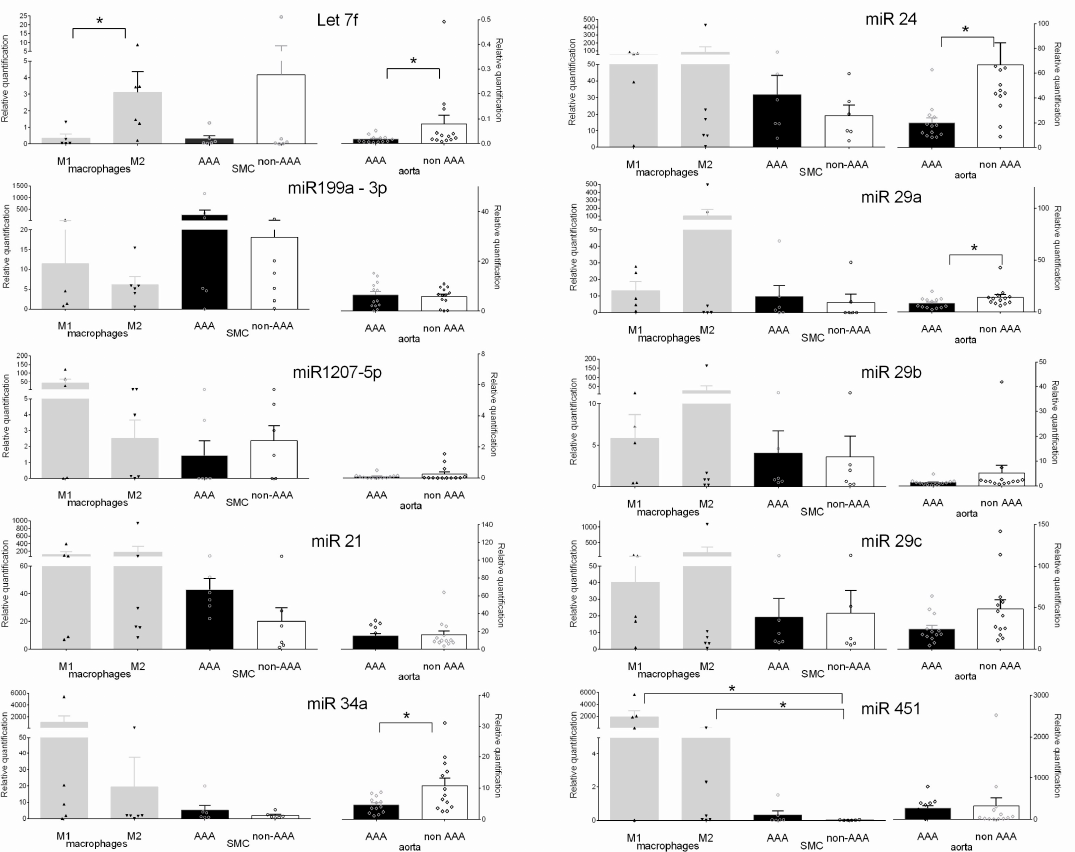
Figure 3. Quantification of the ten miRNAs selected in LCM-isolated cells and in the whole aortic biopsy samples by RT-qPCR with the Δ C t method. Differential expression in isolated aneurysmal SMCs ( n = 6), M1 ( n = 5), and M2 macrophages ( n = 6) was quantified with isolated control SMCs as the reference and RNU6-2 for calibration. Differential expression in the whole aneurysmal aorta samples ( n = 13) was quantified with the control aortas ( n = 13) as the reference and RNU6-2 for calibration. Data were expressed as mean 2 −Δ C t ± SEM with individual values indicated by open circles. * p < 0.05.